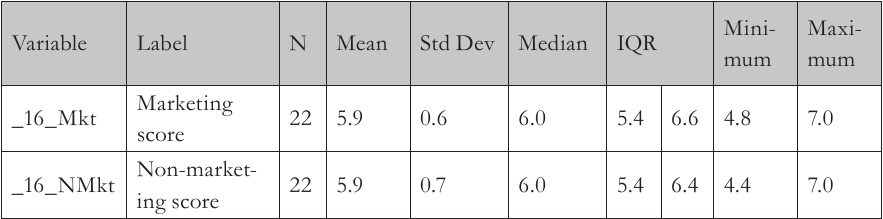
Tab. 3 – BI Managers Marketing and non-Marketing scores for Marketing Manager